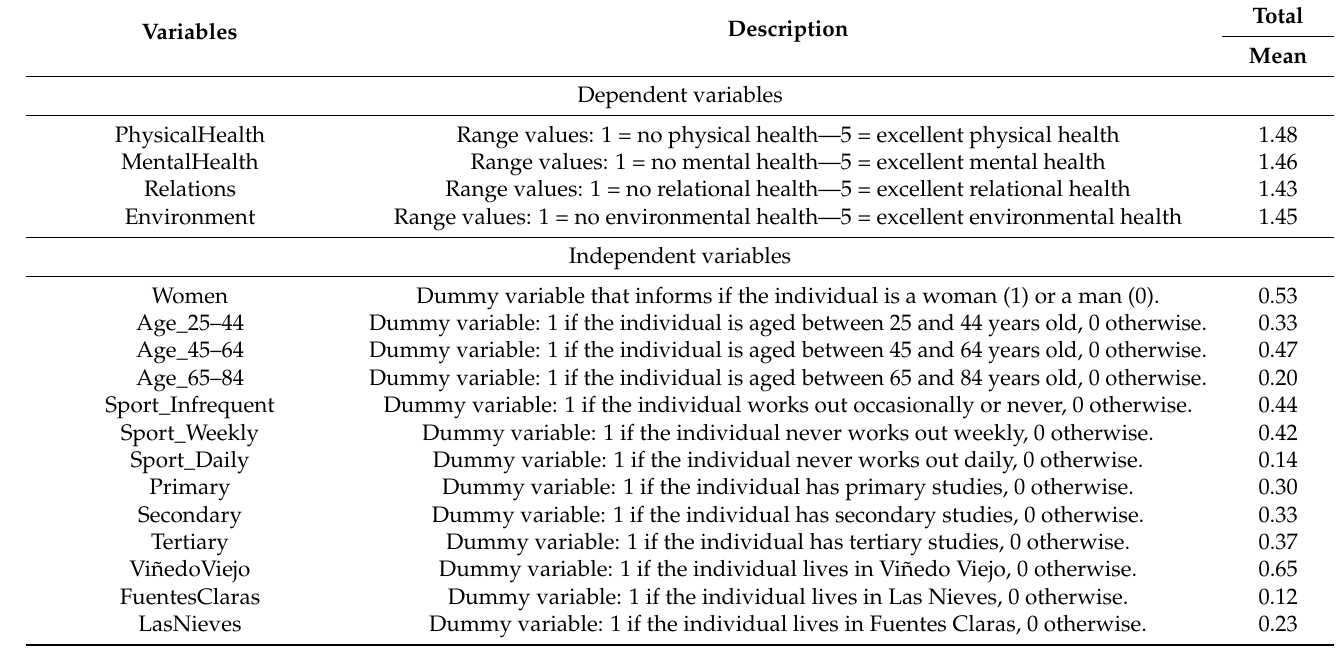
Table 2. Average median of the dependent variables and mean of explanatory variables ( n =